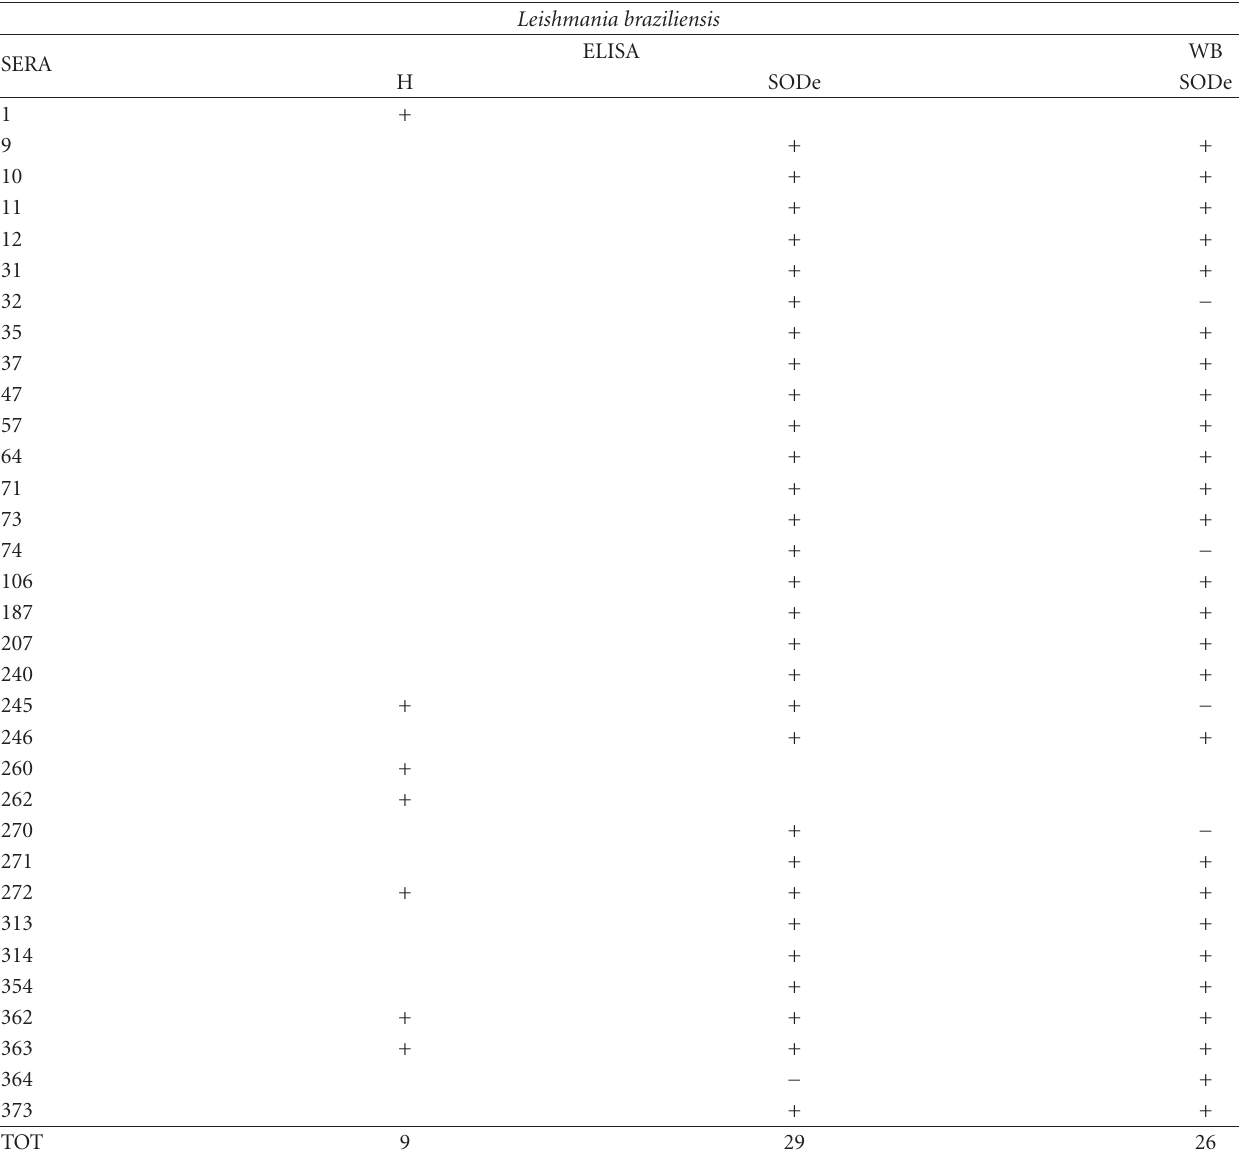
Table 2: The relationship between positive sera of dogs from the Peninsula of Yucatan (Mexico) and Trypanosomatids, by ELISA and Western blot analysis, against di ff erent antigen fractions of Leishmania braziliensis .